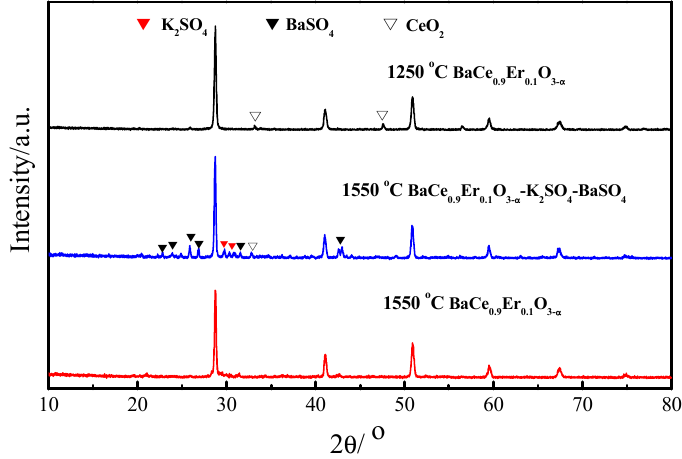
Figure 1. XRD patterns of BaCe 0.9 Er 0.1 Os 3- α (1250 and 1550 °C) and BaCe 0.9 Er 0.1 O 3 −α –K 2 SO 4 –BaSO 4 .